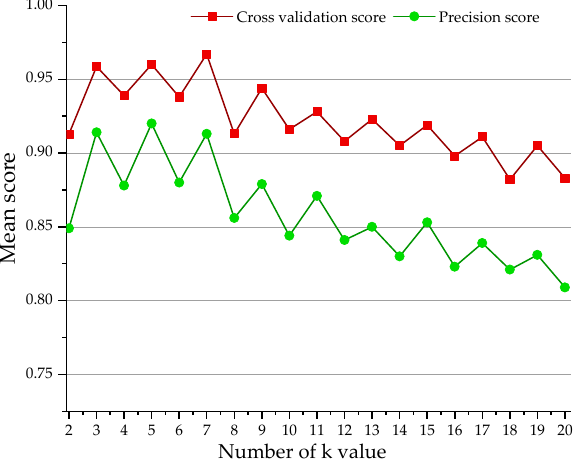
Figure 11. Mean score vs. number of nearest neighbors.